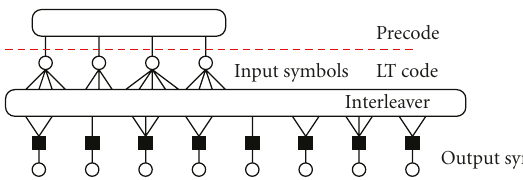
Figure 1: Description of a Raptor code. Tanner graph of an LT code + precode. The black squares represent parity-check nodes and the circles are variable nodes associated with input symbols or output